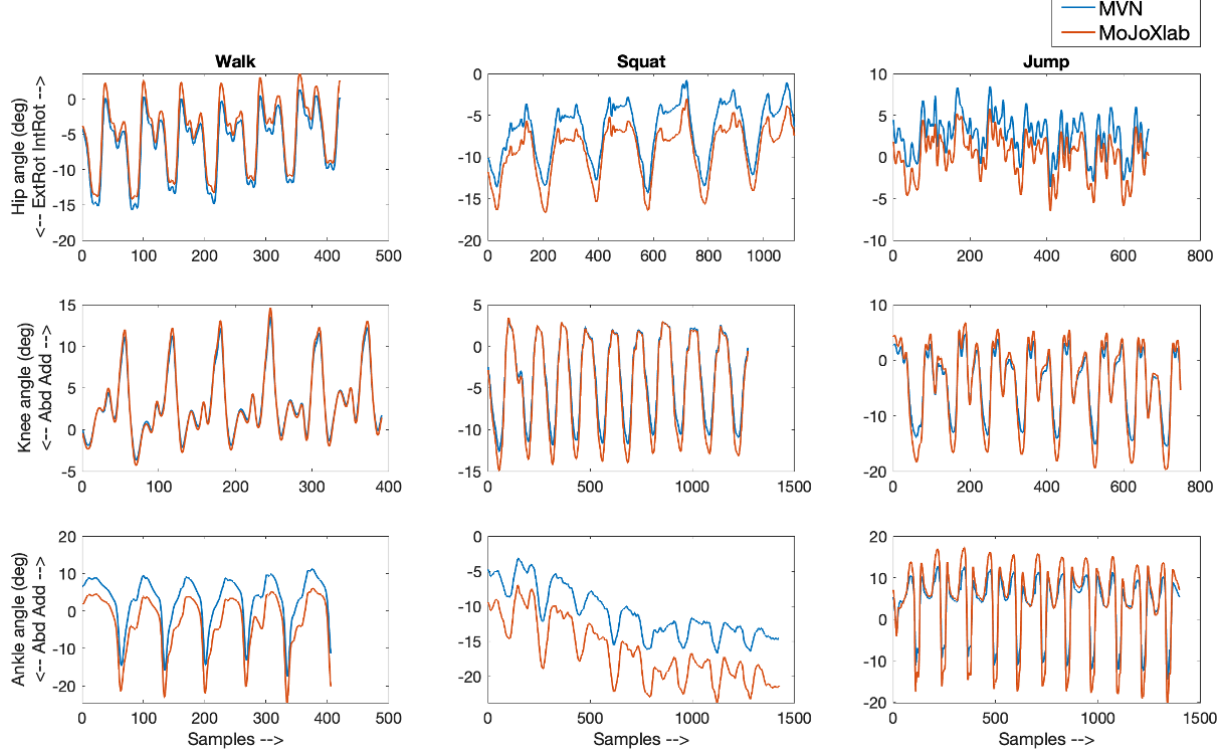
Figure 3. Representative frontal plane joint angle waveforms from the healthy participant data set. Waveforms for the hip (top row), knee (middle row), and ankle (bottom row) joint angles obtained from MVN Analyze (blue) and our custom software MoJoXlab (orange) for walking (left), squatting (center), and jumping (right) tasks. The y-axis represents joint angles in degrees, and the x-axis represents data samples across the entire waveform.